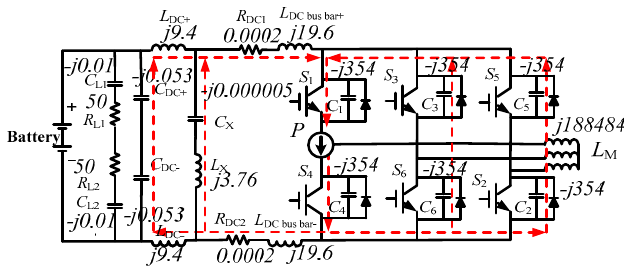
Figure 6. DM interference propagation path at 30 MHz.